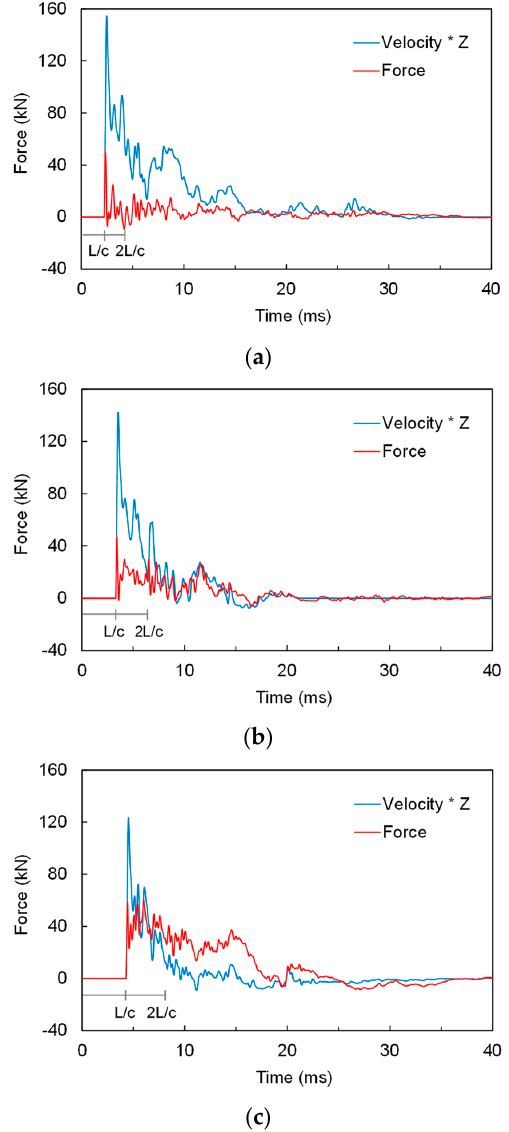
Figure 13. Typical dynamic responses measured at the penetration depth of 100 mm: ( a ) 8 m; ( b ) 14.5 m; ( c ) 20 m. Zero on the x-axis corresponds to the initial rising time of the force and velocity at the rod head.